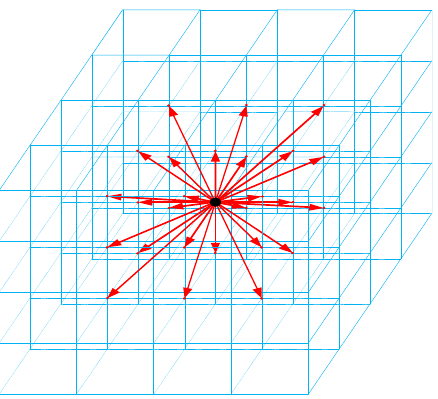
Figure 4. Schematic diagram of the discretization of AUV’s motion direction in the grid.